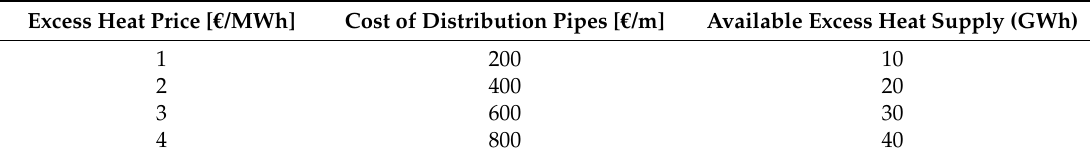
Table 3. Different excess heat prices, costs of pipes, and available excess heat supply used in the analysis of excess heat utilization.